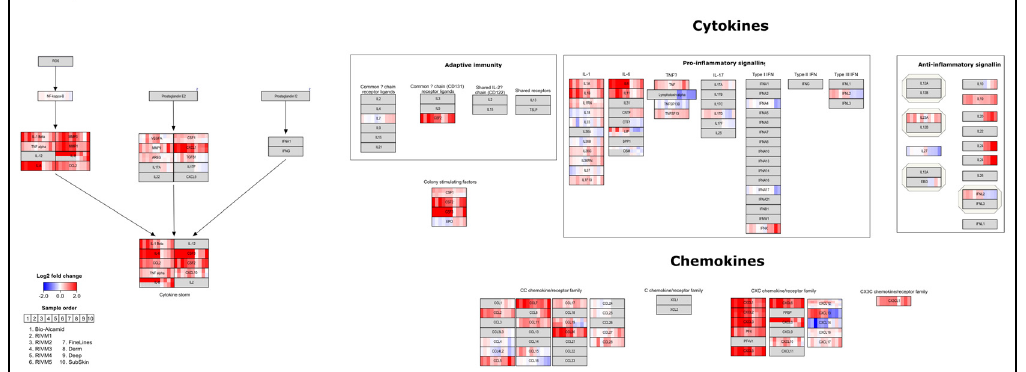
Figure 2. Visualization of gene expression changes for the Phenion ® Full-Thickness Skin model exposed to Bio-Alcamid ® , RIVM preparations and Perfectha ® fillers on the “Overview of proinflam- matory and profibrotic